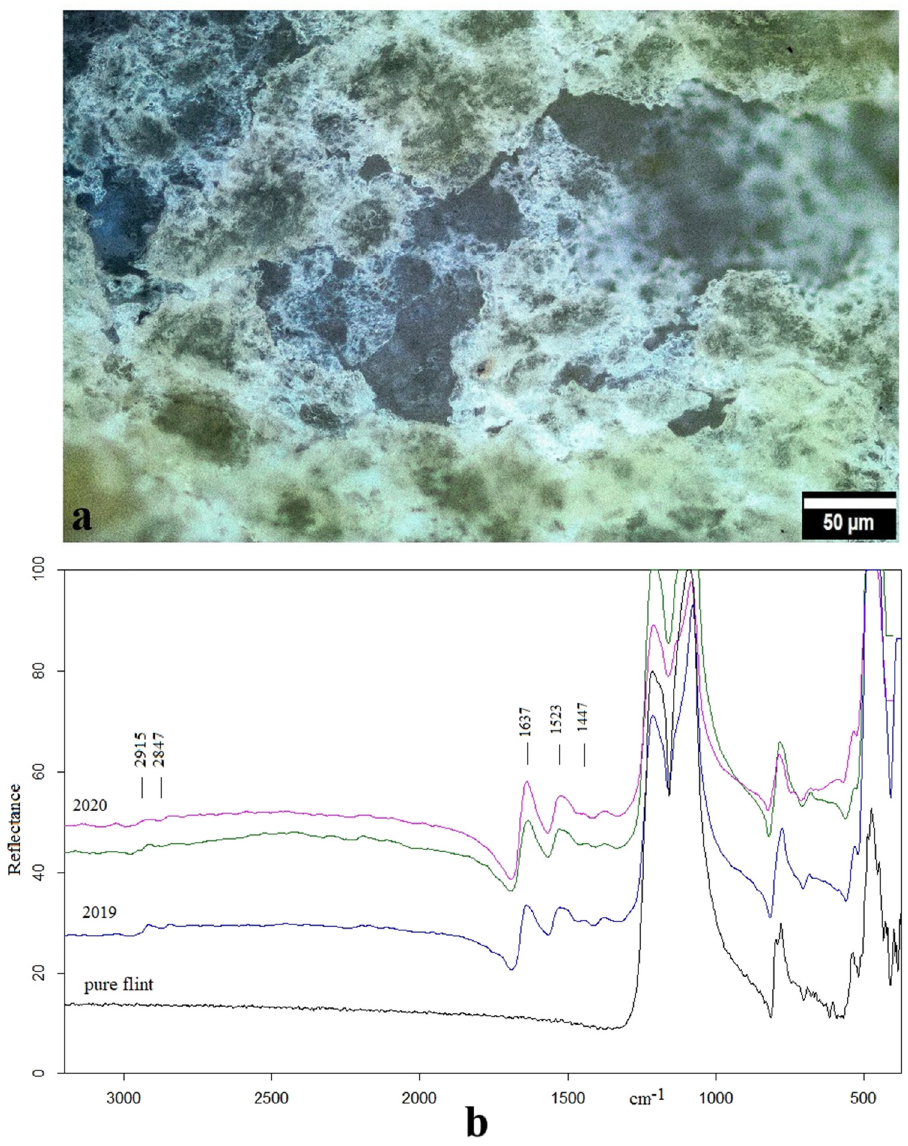
Figure 6: ( a ) Residues, ( b ) FTIR spectra showing collagen, the analysis done 5 days after the experimentation ( March 2019 ) , and the second analysis, done after 1. 4 years ( July 2020 ) – AMIDE I and II from collagen and working of the meat and organs ( FTIR spectra S. Nunziante Cesaro, photo A. Petrovi ć )